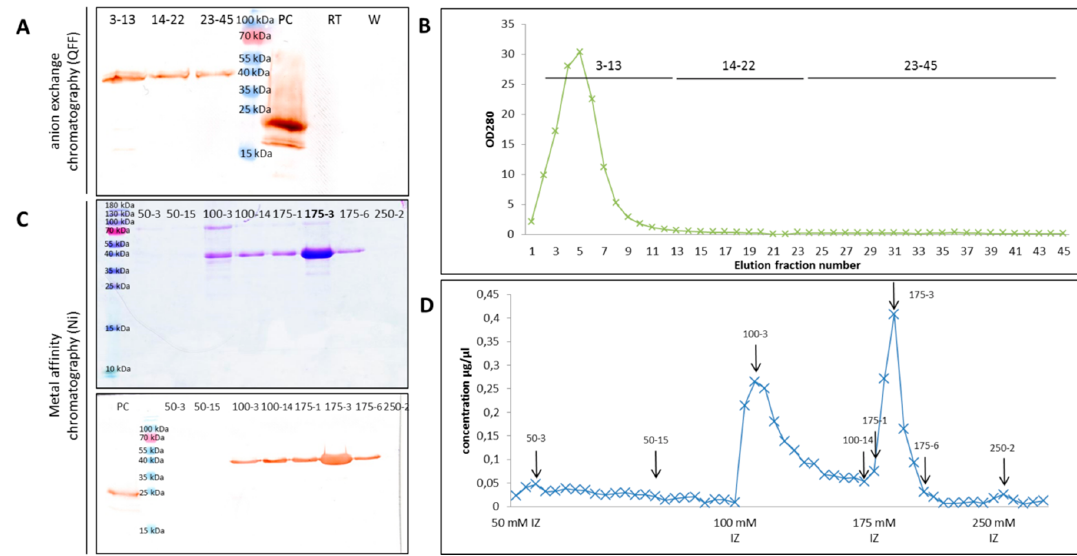
Figure 6. ArathEULS3 protein purification. ( A ) Western blot analysis of proteins eluted from anion exchange chromatography on Q Fast Flow (QFF). RT—run through, PC—HIS-tagged positive control protein (lectin domain of OsEULS2, LOC_Os07g48500.1, MW: 22.8 kDa), and W—wash. ( B ) Graph illustrating the elution fractions from the QFF column. Samples indicated are analyzed in panel A. ( C ) SDS-PAGE and Western blot analysis of proteins eluted from metal affinity chromatography (Ni-NTA agarose beads). ( D ) Graph illustrating the elution fractions from the Ni-NTA column. Arrows indicate the samples analyzed in panel C.